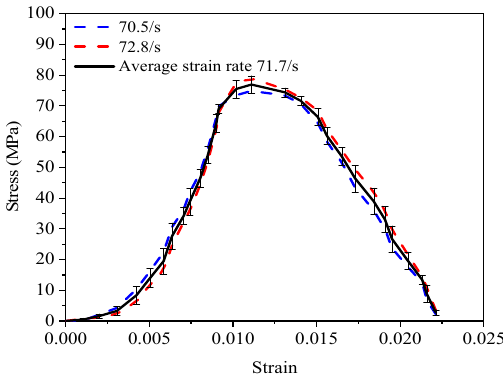
Figure 6. Example of obtaining the dynamic compressive stress-strain curve.